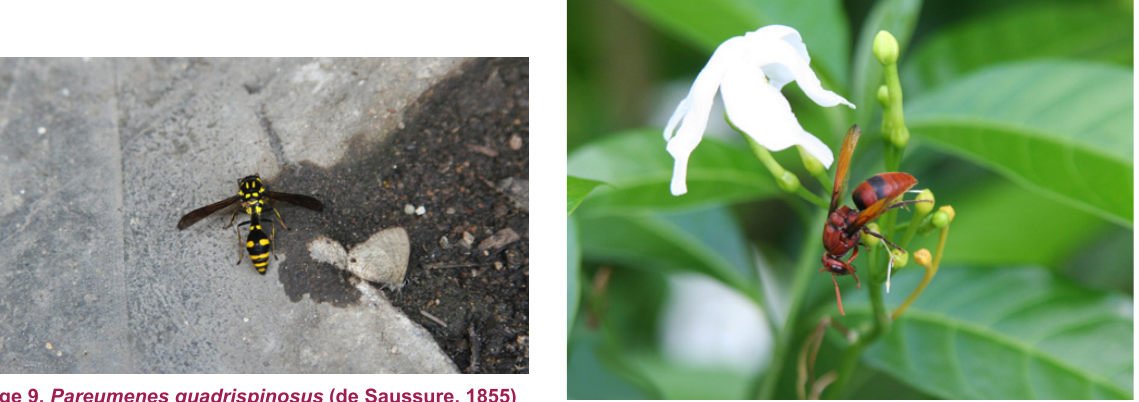
Legs brownish-red with variegated black markings. The